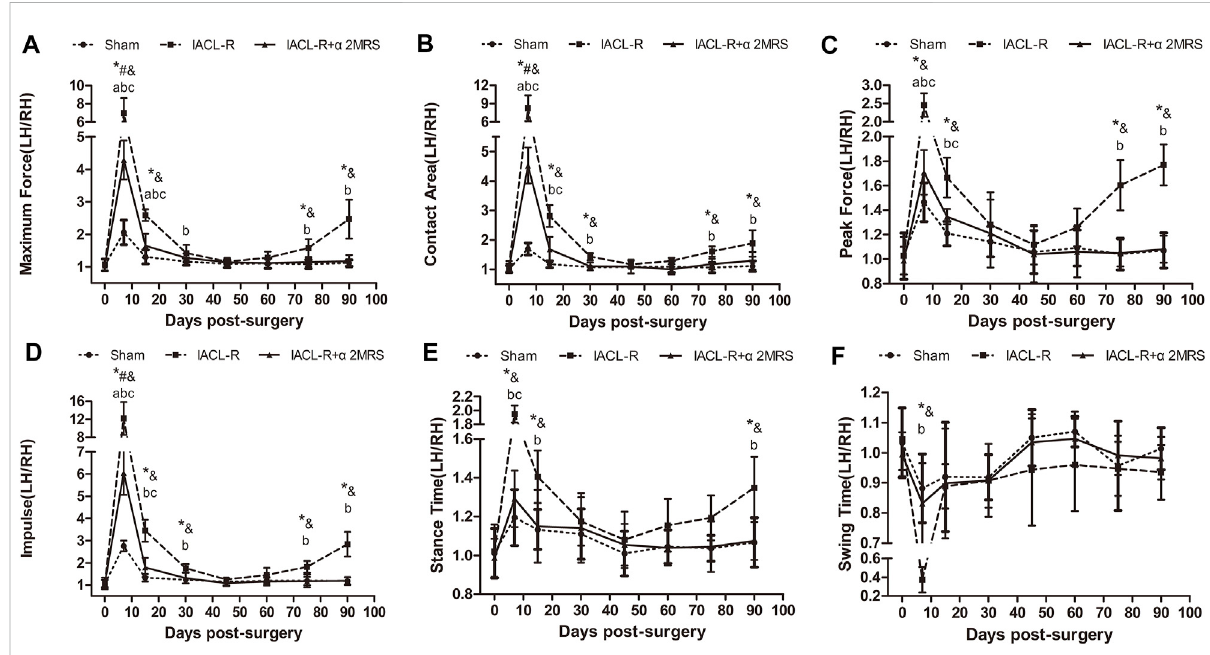
FIGURE 5 Line charts of gait analysis. (A) Maximum force; (B) Contact area; (C) Peak force; (D) Impulse; (E) Stance time; (F) Swing time. * = p < 0.05, sham group versus IACL-R group at the same time point; # = p < 0.05, sham group versus IACL-R+ α 2MRS group at the same time point; and = p < 0.05, IACL-R group versus IACL-R+ α 2MRS group at the same time point. a = p < 0.05, preoperative (day 0) versus postoperative (days 7, 15, 30, 45, 60, 75, and90)intheshamgroup;b= p < 0.05,preoperative(day0)versuspostoperative(days7,15,30,45,60,75,and90)intheIACL-Rgroup;c= p < 0.05, preoperative (day 0) versus postoperative (days 7, 15, 30, 45, 60, 75, and 90) in the IACL-R+ α 2MRS group. The bars show the mean ± SD (n =